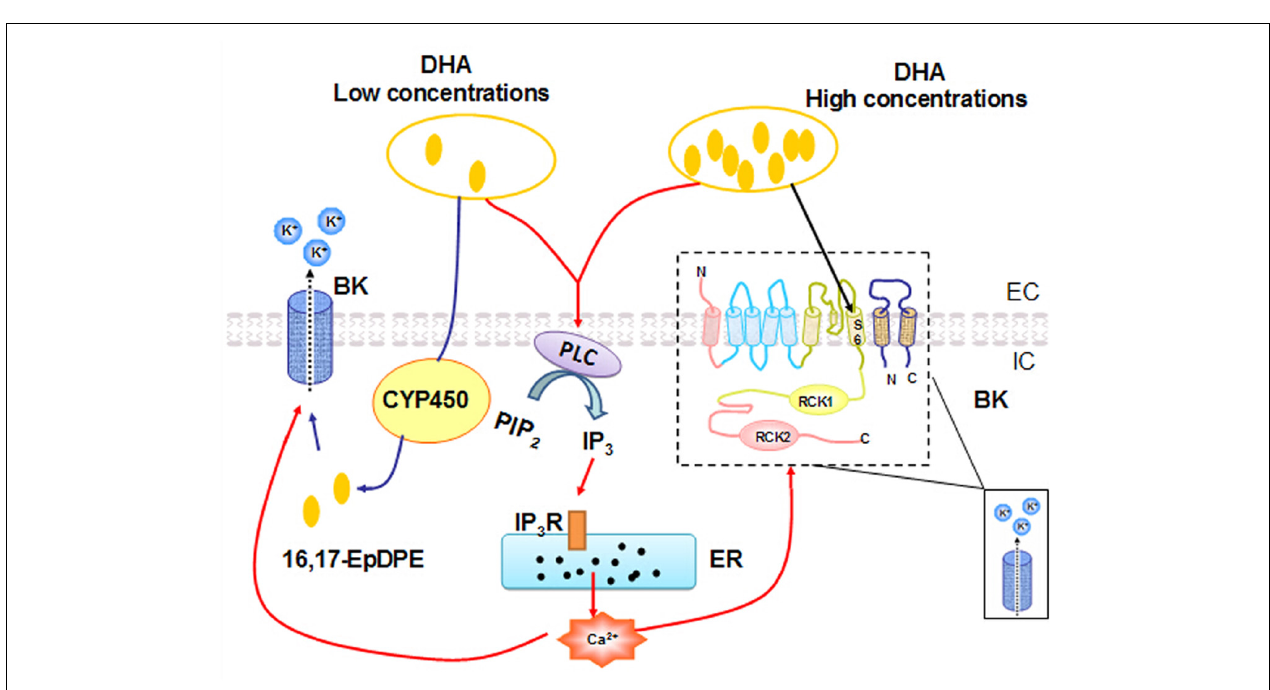
FIGURE 7 | A proposed model for BK channel activation mechanisms by different concentrations of DHA. Low concentrations of DHA-induced BK channel activation are dependent on CYP epoxygenase activity. High concentrations of DHA activate BK channels directly. In addition, DHA can also induce a dose-dependent increase in [Ca 2 + ] i via the PLC–IP 3 –Ca 2 + signal pathway, and the ensuing increased [Ca 2 + ] i can activate BK channels in rat CASMC.